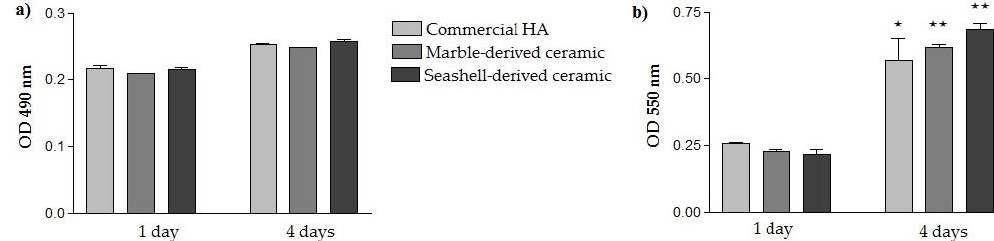
Figure 5. Cellular survival and proliferation of MC3T3-E1 pre-osteoblasts grown on tested substrates for 1- and 4-day culture periods. ( a ) LDH quantification as a measure of the ceramics’ cytotoxicity ( n = 3, mean ± SD); ( b ) MTT results showing the proliferation of cells cultured on 0.785 cm 2 of commercial HA, marble- and seashell-derived HA ( n = 3, mean ± SD). ⋆ p ˂ 0.05 for commercial HA, 4 day-culture vs. 1 day-culture, ⋆⋆ p ˂ 0.01 for marble-derived ceramic, 4 day-culture vs. 1 day-culture, ⋆⋆ p ˂ 0.01 for seashell-derived ceramic, 4 day-culture vs. 1 day-culture.